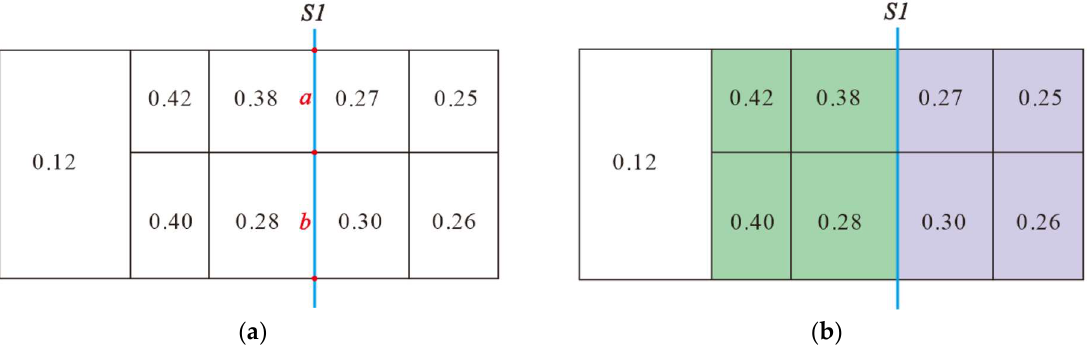
Figure 7. Maintaining the connectivity of the road network while eliminating road segments: ( a ) a road stroke across the aggregated area; and ( b ) splitting the aggregated area into two sub-aggregated areas based on this stroke.